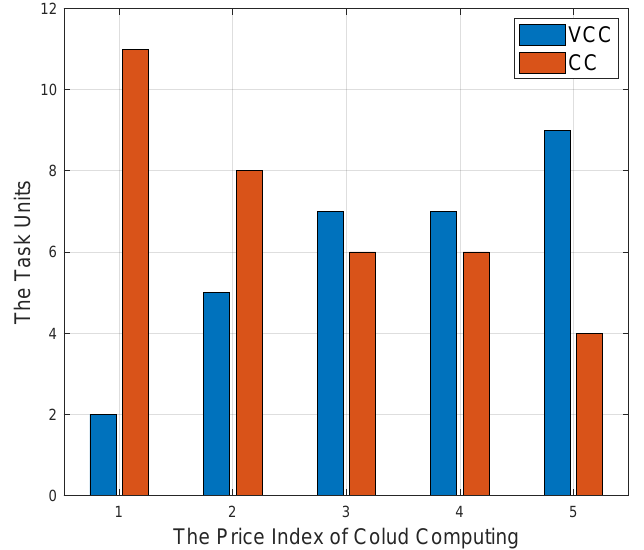
Figure 11. The resource utilization distribution between VCC and RCC with the increasing price of computation resource on